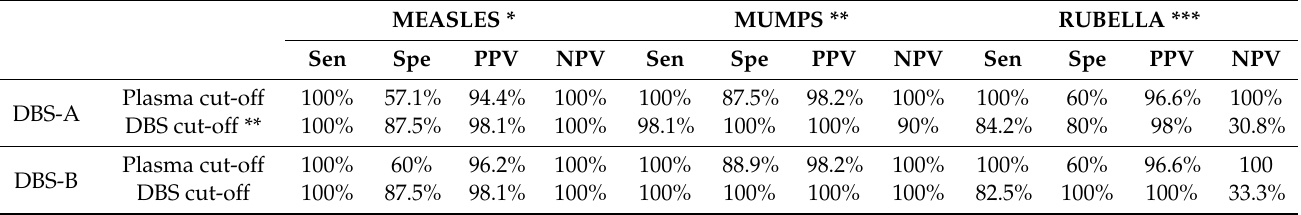
Table 3. Results of VirClia ® -IgG test for the detection of protective IgG against measles, mumps and